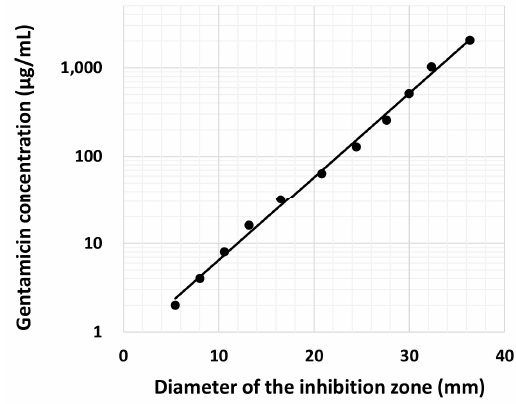
Figure 5. Relationship between gentamicin concentrations and the diameters of the inhibition zone in an agar plate coated with Staphylococcus aureus .